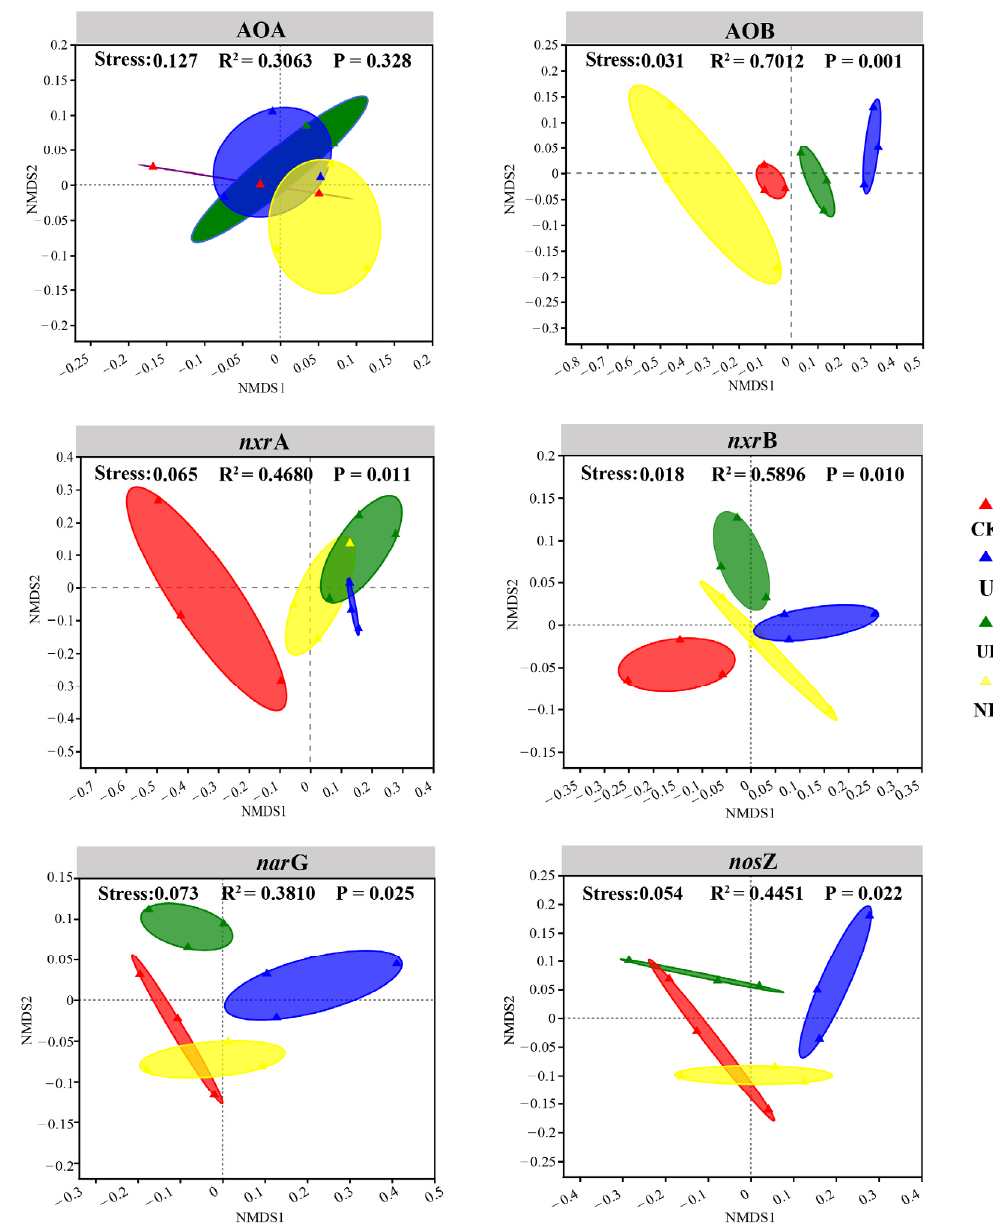
Figure 3. Non-metric multidimensional scaling (NMDS) analysis at the OTU level of AOA, AOB, nxrA -bearing, nxrB -bearing, narG -bearing, and nosZ -bearing bacterial population. Treatments were as follows: CK: no nitrogen fertilizer application; U: urea; UI: urea with 0.4% NBPT; and NI: urea with 1% DMPP. The additional stress values at the top are the results of analyses of similarities (ANOSIM) with 999 permutations.